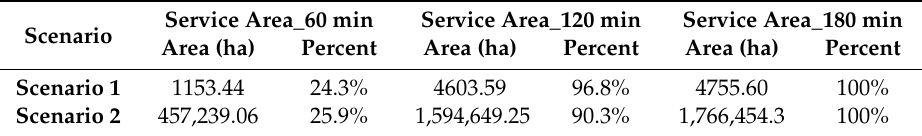
Table 5. Service area within different travel time blocks. Most suitable sites are shown to be between 1 and 2 h travel time to the biomass refineries.